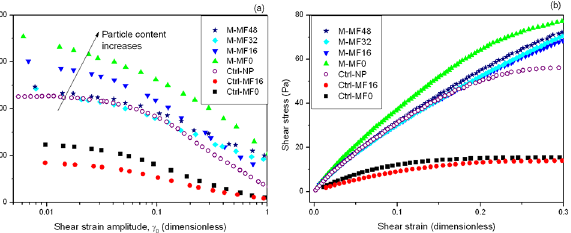
Fig 5. Mechanical properties of tissue substitutes in the absence of a magnetic field. (a) Elastic modulus as a function of the amplitude of shear strain in oscillatory tests at an oscillation frequency of 1 Hz. (b) Shear stress as a function of shear strain obtained under steady-state conditions. Experimental groups: Ctrl-MF0 and Ctrl-MF16: control (nonmagnetic) tissue substitute without particles, gelled in the absence of a magnetic field or during application of a 16 kA m -1 field, respectively; Ctrl-NP: control (nonmagnetic) tissue substitute with nonmagnetic polymer particles; M-MF0: magnetic tissue substitute gelled in the absence of a magnetic field; M-MF16, M-MF32 and M-MF48: magnetic tissue substitutes gelled during application of a 16 kA m -1 , 32 kA m -1 or 48 kA m -1 field, respectively.